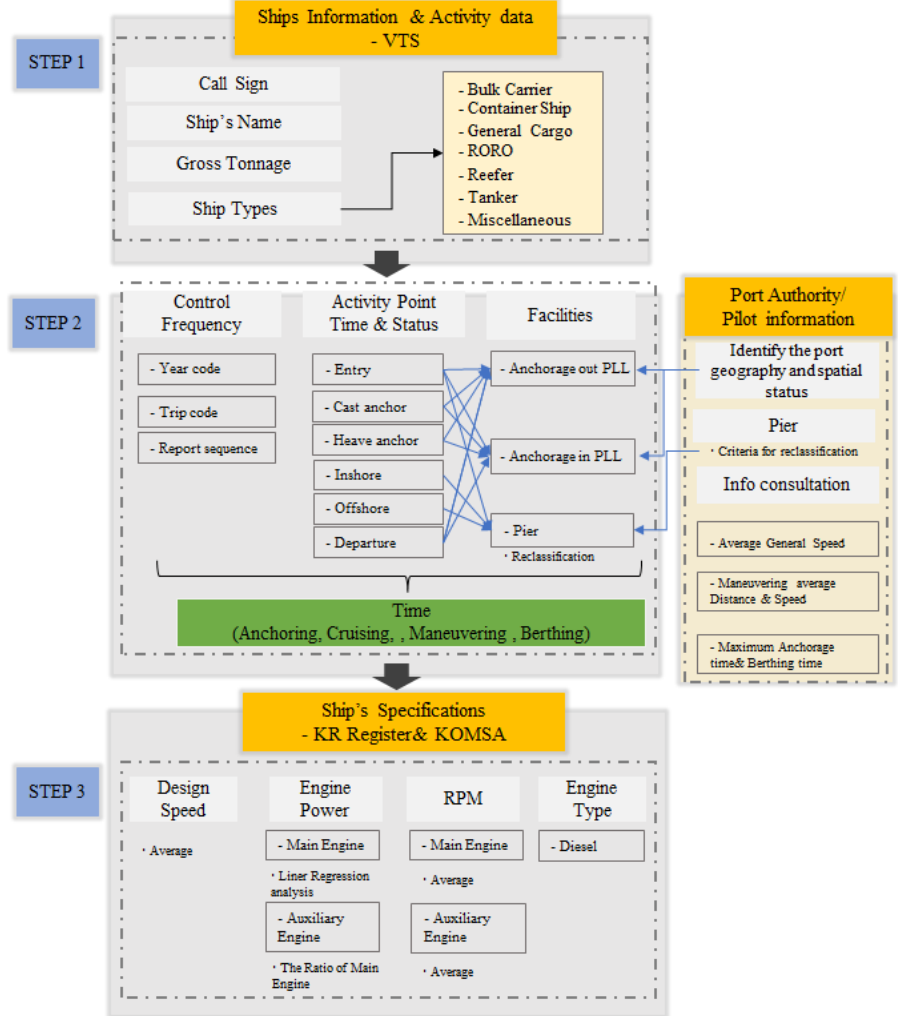
Figure 2. The process of data collection and analysis.